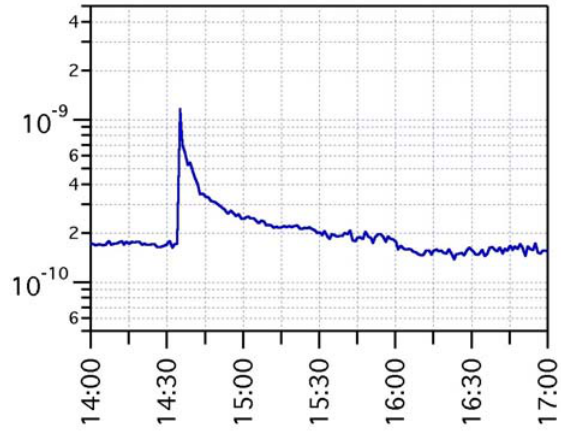
Figure 10. Zoom-in of 11-12-2010 event, appearing in Figure 9 as just a vertical line: as shown here, this is a real sensing event, with sharp onset and about 1 h recovery time. Vertical log scale emphasizes an almost tenfold change in sensing layer resistance